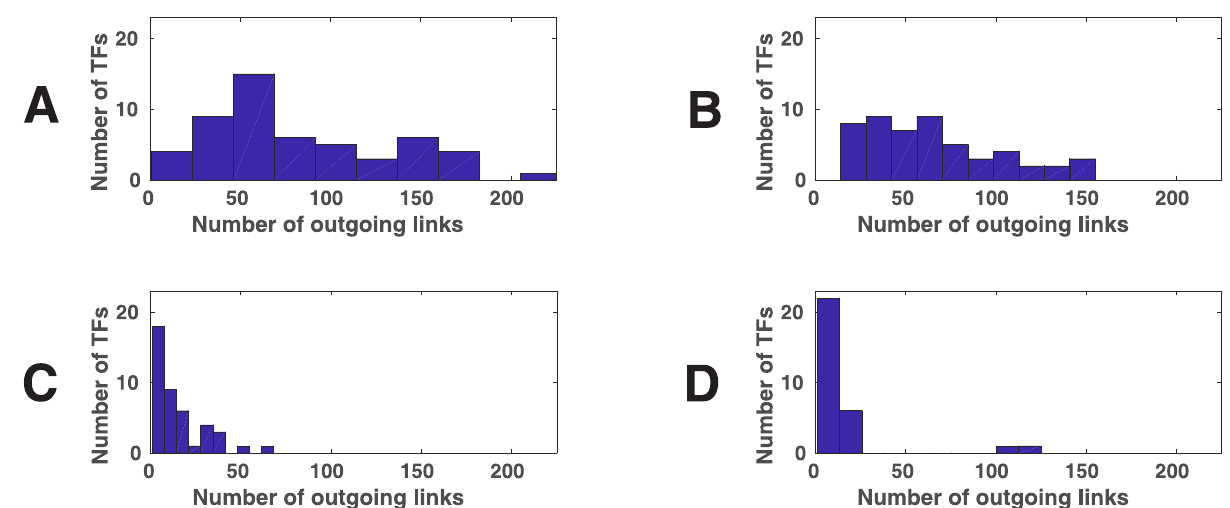
Fig 3. Link distribution in different classes. The distribution of the number of outgoing links per node is shown for (A) WN, (B) C 3 , (C) C 2 , and (D) C 1 , where C k denotes the set of links in Class k (see the text for the definition of the link classes). The figure indicates that the distributions of links in C 2 (panel C) and C 1 (panel D) are much more non-uniform in comparison with that of links in C 3 . In C 1 and C 2 OCT4 and SOX2 have the largest number of outgoing links. The gap between these two TFs and others is especially large in C 1 (panel D), indicating the importance of OCT4 and SOX2 in C 1